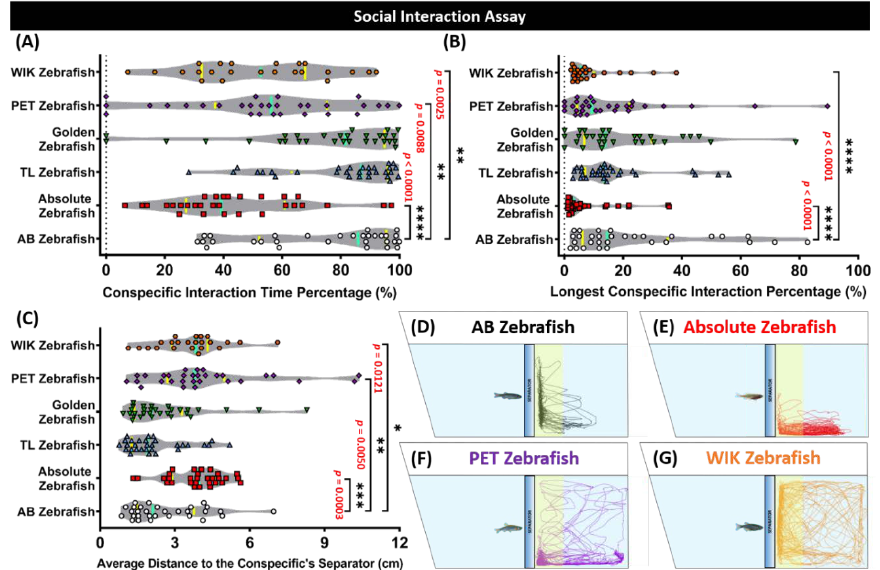
Figure 4. Social interaction behavior endpoint comparisons between the AB zebrafish (white), absolute zebrafish (red), TL (Tübingen Long Fin) zebrafish (blue), golden zebrafish (green), PET (Pet Store-purchased) zebrafish (purple), and the WIK (Wild Indian Karyotype) zebrafish (orange). ( A ) Conspecific interaction time percentage, ( B ) longest conspecific interaction percentage, and ( C ) the average distance to the conspecific’s separator were analyzed for the social interaction assay. The median and the interquartile for the violin plot were labeled with the bold line colored with cyan and yellow, respectively. The 5 min locomotor trajectories for the AB, absolute, PET, and WIK zebrafish are presented in ( D – G) , respectively, with the yellow colored zone as the interacting conspecific region. The data were analyzed by a Mann–Whitney test ( n = 30 for each group, except for the WIK zebrafish ( n = 23); * p < 0.05; ** p < 0.01; *** p < 0.001; **** p < 0.0001).